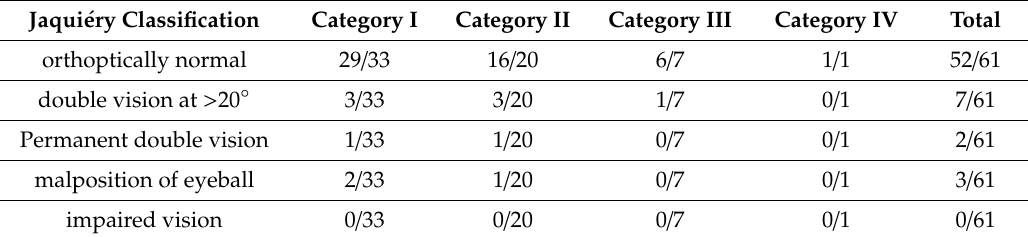
Table 3. Late ophthalmologic and orthoptic follow-up in 61